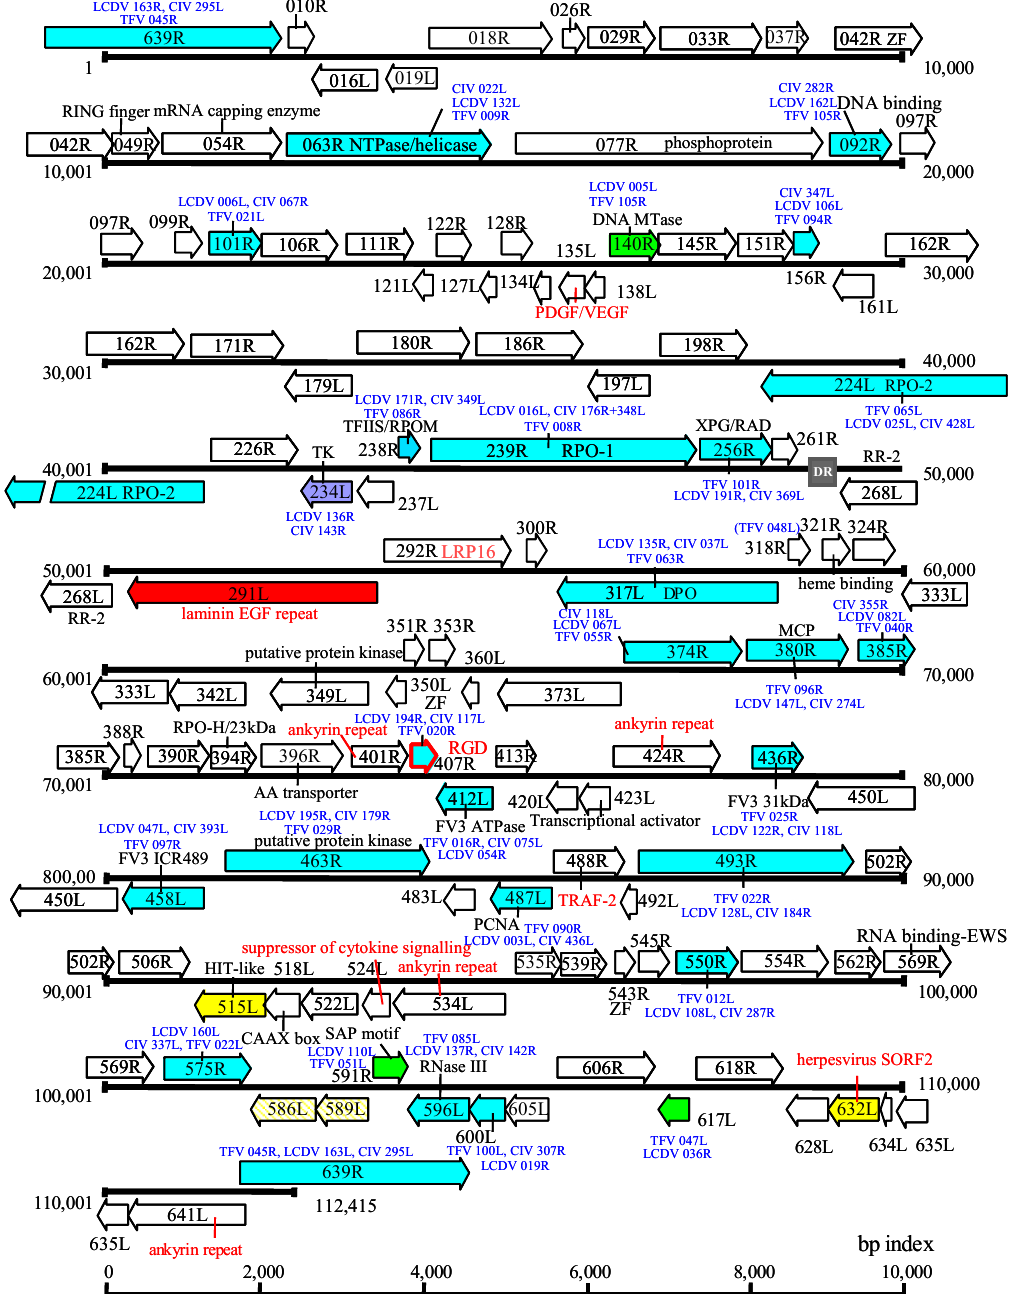
Figure 3. Genome structure of RSIV-Ehime 1 strain. Blue arrows indicate genes common among the Megalocytivirus , Ranavirus , Lymphocystivirus and Iridovirus genera. Green arrows show genes found among all vertebrate iridoviruses. The single purple arrow shows a gene which is not encoded by the genus Ranavirus. Yellow arrows show RSIV-specific genes, red annotations indicate putative virus-host interaction genes, and the red arrow shows a possible attachment protein